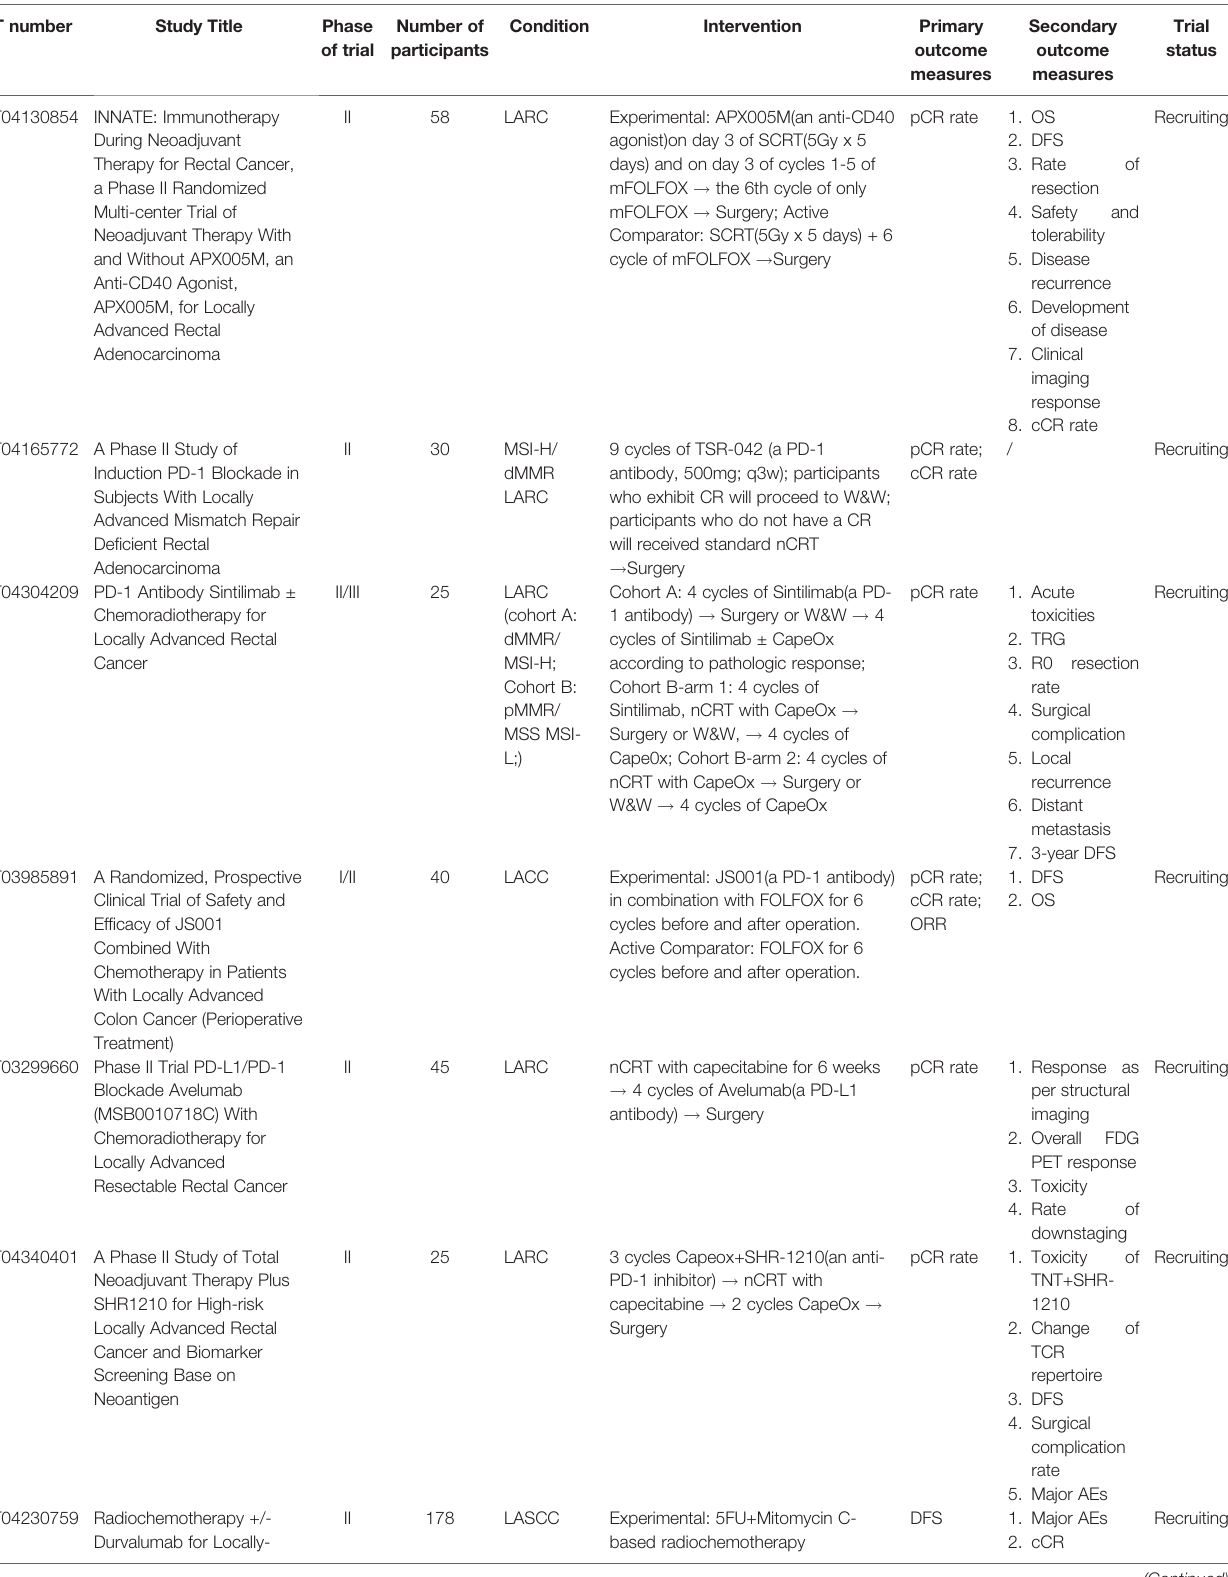
TABLE 2 | Ongoing clinical trials of nIT for